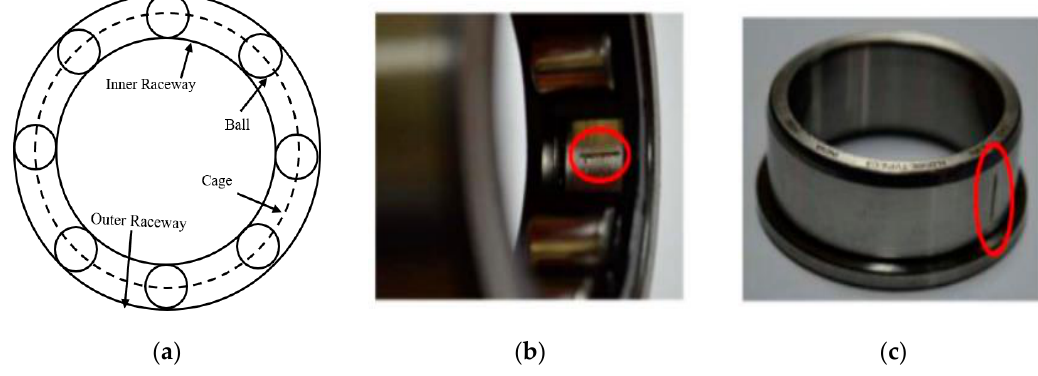
Figure 5. ( a ) Structure of a rolling-element bearing; ( b ) Outer race defect; ( c ) Inner race defect.